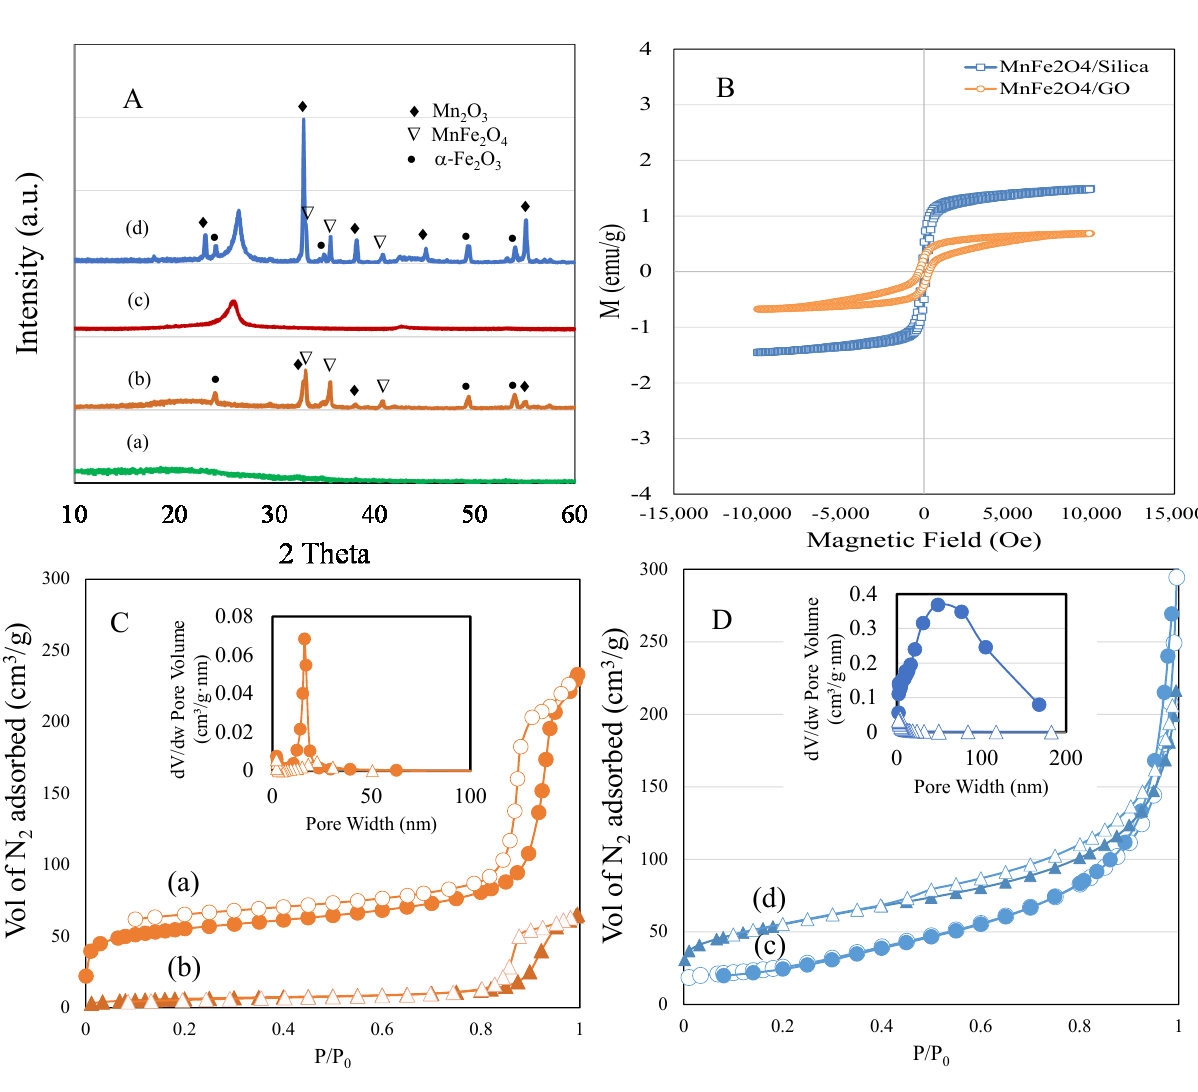
Figure 1. ( A ) (a–d). XRD powder patterns of: (a) silica; (b) MnFe 2 O 4 /silica; (c) GO; and (d) MnFe 2 O 4 /GO. ( B ) Vibrating sample magnetometer spectrum of MnFe 2 O 4 /silica and MnFe 2 O 4 /GO. ( C ) (a,b). BET adsorption–desorption isotherm and pore size distributions of: (a) silica; and (b) MnFe 2 O 4 /silica. ( D ) (c) GO; and (d) MnFe 2 O 4 /GO. Closed symbol represents adsorption and open represents desorption.